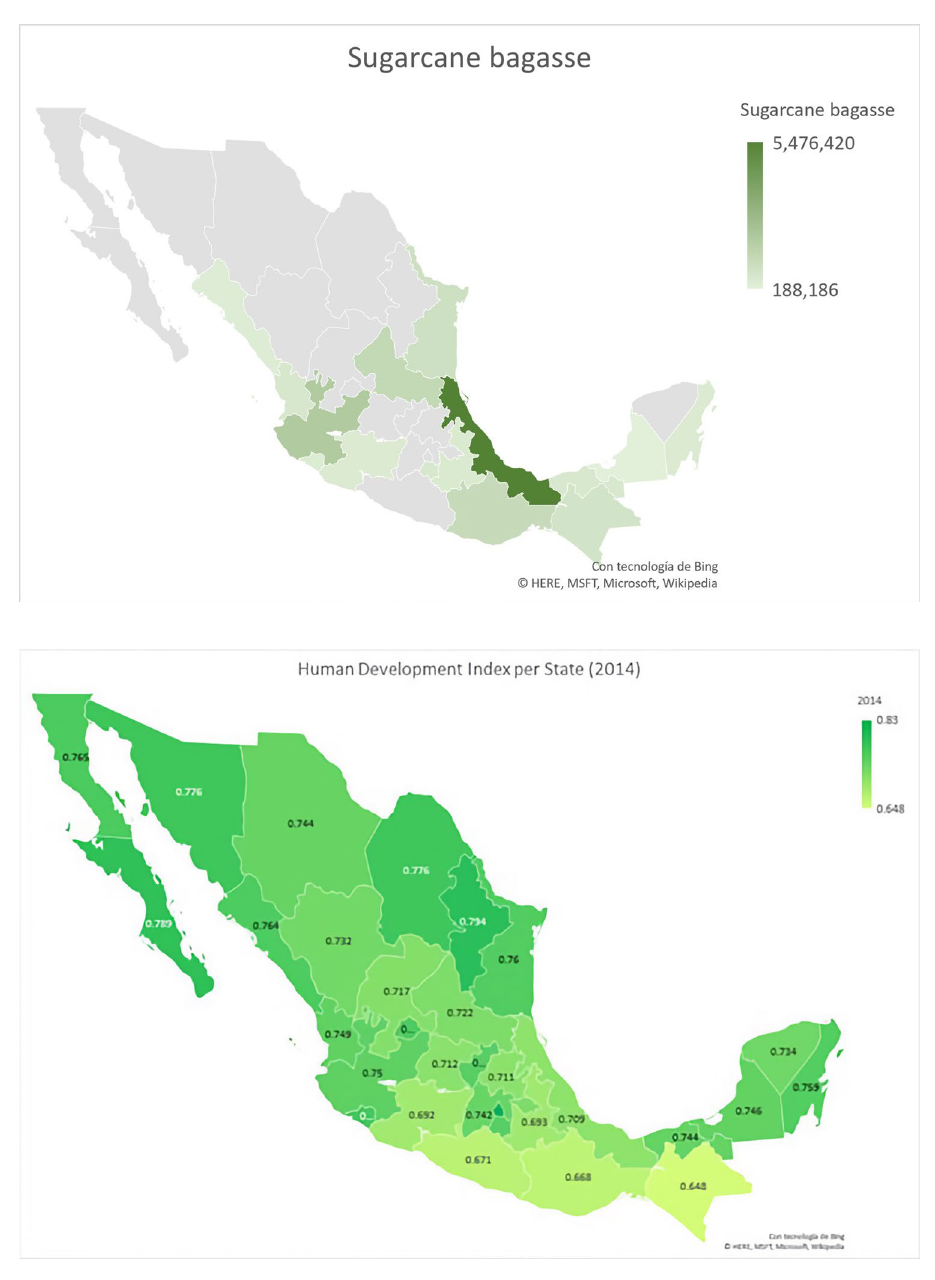
Fig. 6 Sugarcane bagasse availability (Mg/year) [Choro-